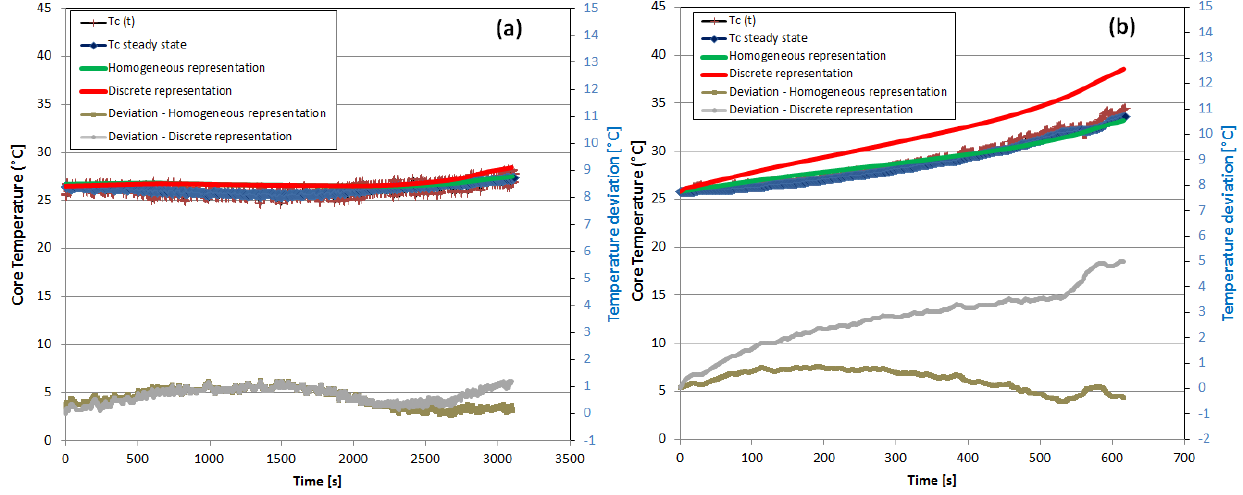
Figure 15. Evolution of the core temperature during: ( a ) 1 I